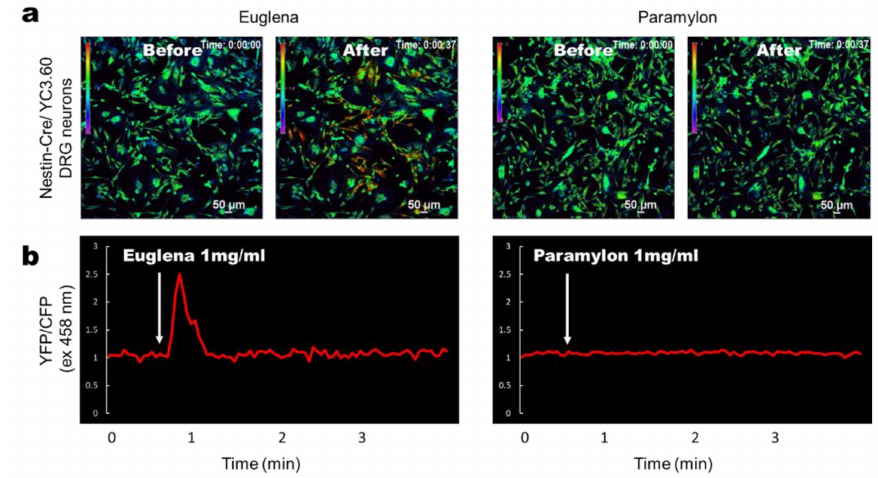
Figure 3. Ca 2 + signaling images using Euglena and Paramylon in dorsal root ganglia (DRG) neurons in vitro. ( a ) Representative ratiometric Ca 2 + signaling images in DRG cells from YC3.60 flox / Nestin-Cre mice showing YFP / CFP excitation at 458 nm. Euglena or paramylon (0.1 mL) in PBS (1 mg / mL) was added to the cell culture at the indicated time point. The color scale indicates relative Ca 2 + concentration. ( b ) Time course of ratiometric YFP / CFP fluorescence intensity at 458 nm excitation. Results are representative of at least three independent experiments ( n = 9 mice; scale bars, 50 µ